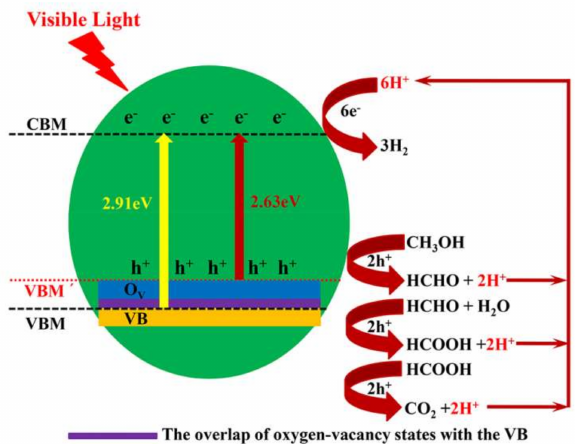
Figure 10. Schematic diagram illustrating the mechanism of the charge separation and photocatalytic reaction for the Bi 4 Ti 3 O 12 − x photocatalyst under visible-light irradiation. VB: valence band; CBM: conduction band minimum; and VBM: valence band